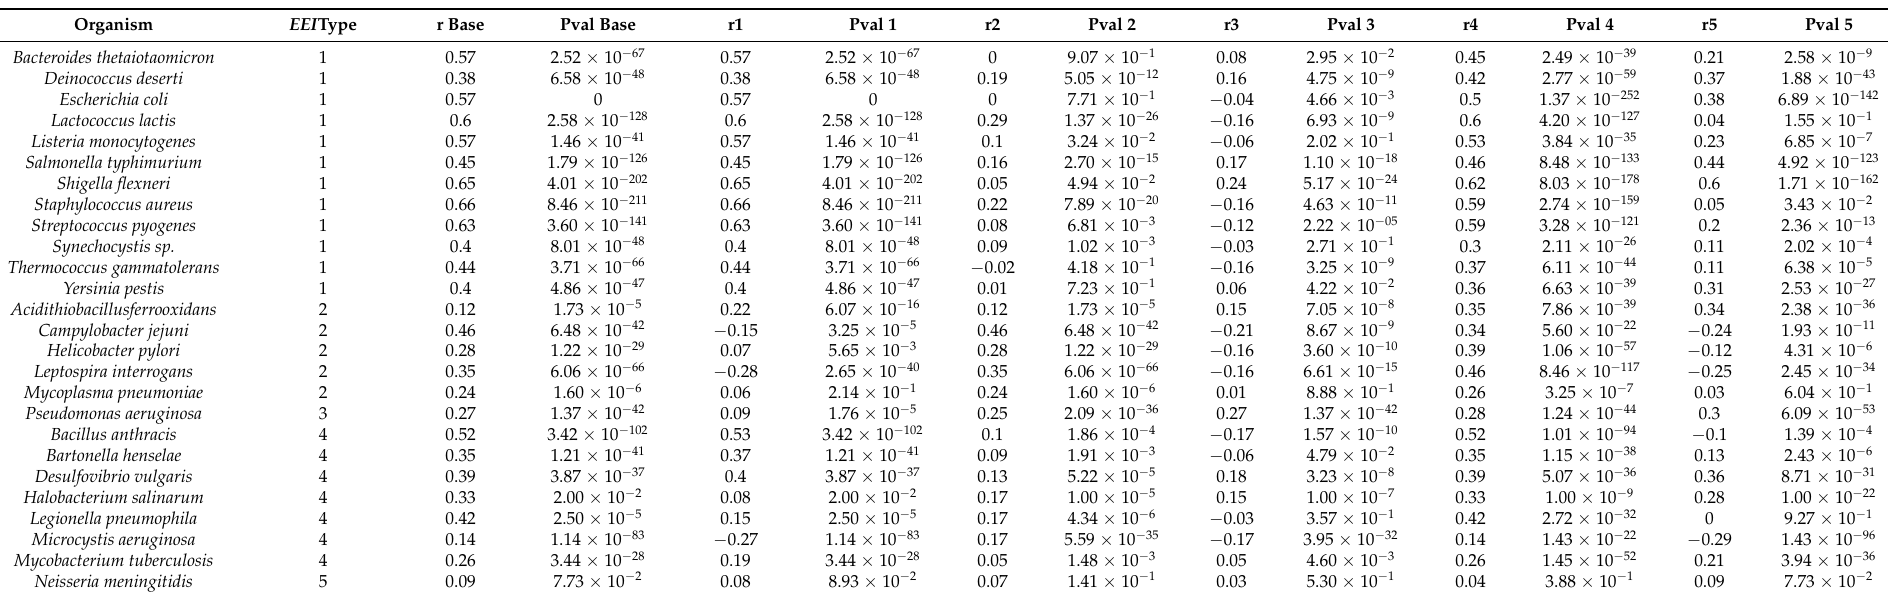
Table A1. The table represents Pearson’s correlations between measured protein abundance and elongation efficiency indices calculated by EloE and corresponding p -values. These correlation coefficients have been evaluated using several EEI values: (a) EEI values which have been calculated for the base EEI type of the studied organism are presented in the “r base” column with the p -value in the “Pval base” column, and the base EEI type is presented in the “ EEI type” column and represents which of the five EEI types is determined as the type of the organism under study; (b) EEI values which were calculated for the each EEI type (1–5), the correlation coefficients and the p -values presented in the “r” and “Pval” columns for each type,